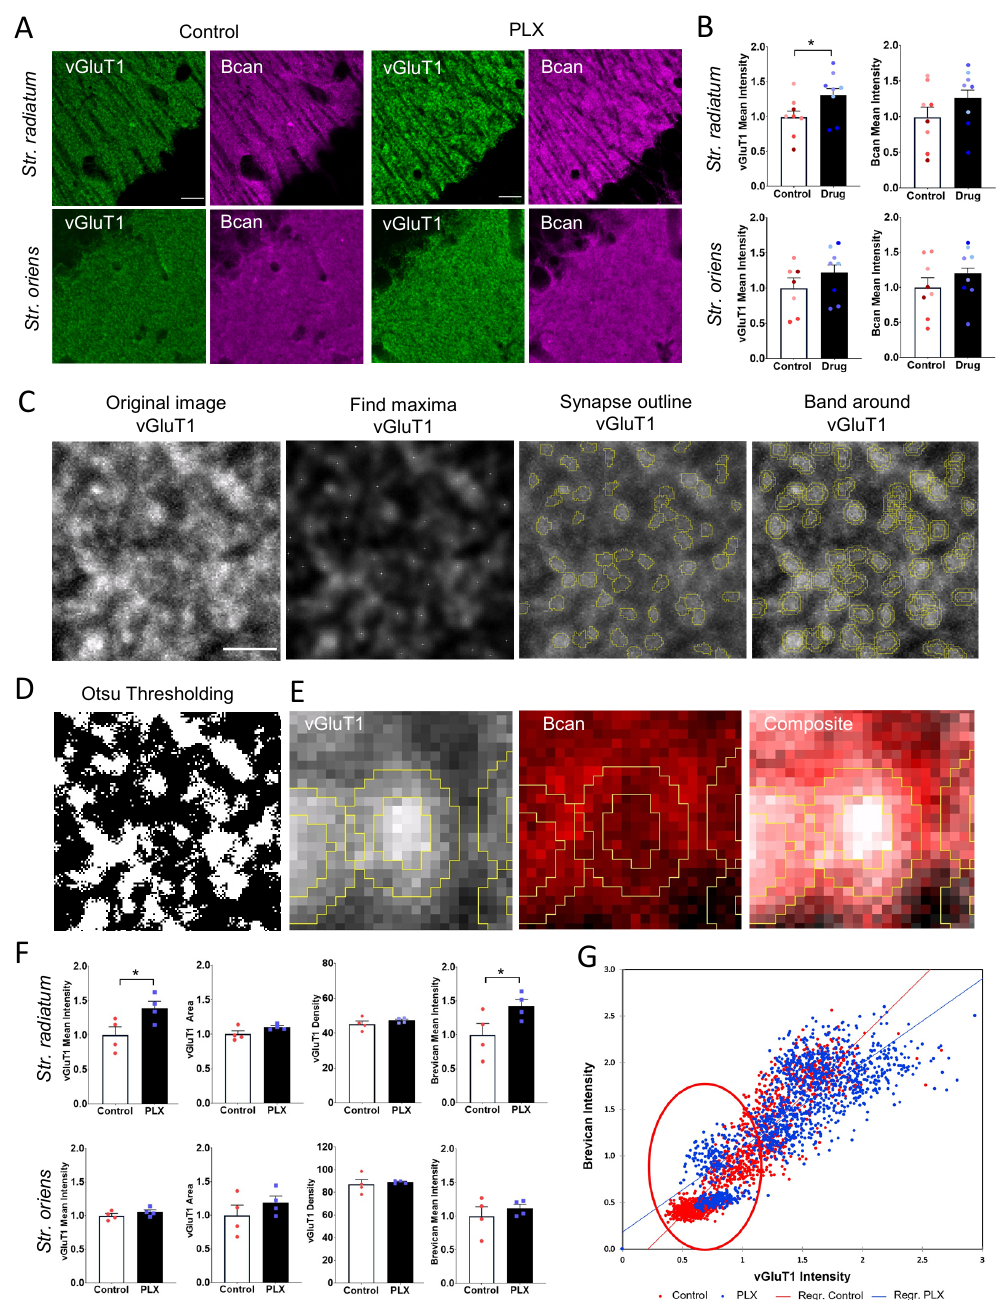
Figure 4. Elevation of presynaptic vGluT1 and perisynaptic Bcan after depletion of microglia. ( A ) Representative 63 × images of adult hippocampal str. radiatum and oriens after PLX treatment and in control. ( B ) Quantification of vGluT1 and Bcan mean intensity per ROI shows upregulation in vGluT1 expression in str. radiatum (* p < 0.05, t -test). Bars show means per animal with superimposed individual values per ROI. Colors indicate ROIs from the same animal. ( C ) ROI showing the representative section of an image acquired with × 63 objective. (1) Original image after maximum projection. (2) After applying the Gaussian filter and enhancing contrast, the Find Maxima algorythm in Fiji ImageJ is used to detect local maxima. (3) Starting from the brightest pixel of each synapse, the outline of the puncta is detected. (4) Then, a band is created, and the mask is applied to the original image to measure size and intensity in the center and the band of the created ROI. ( D ) Using the conventional thresholding methods in Fiji, such as Otsu thresholding, we could not precisely detect synaptic puncta. ( E ) Zoomed image of single presynaptic punctum and surrounding ECM. ( F ) PLX3397 significantly increased the intensity of vGluT1 puncta and the intensity of surrounding perisynaptic brevican in str. radiatum (* p < 0.05, t -test), but not in str. oriens . The density of VGluT1 puncta was not changed. Bars and error bars represent mean ± SEM per animal. Single points on bars represent average values per animal. ( G ) The correlation plot shows a positive correlation between vGluT1 presynaptic intensity and corresponding perisynaptic brevican signal. Scale bar is 15 µ m in ( A ) and 3 µ m in ( C – E